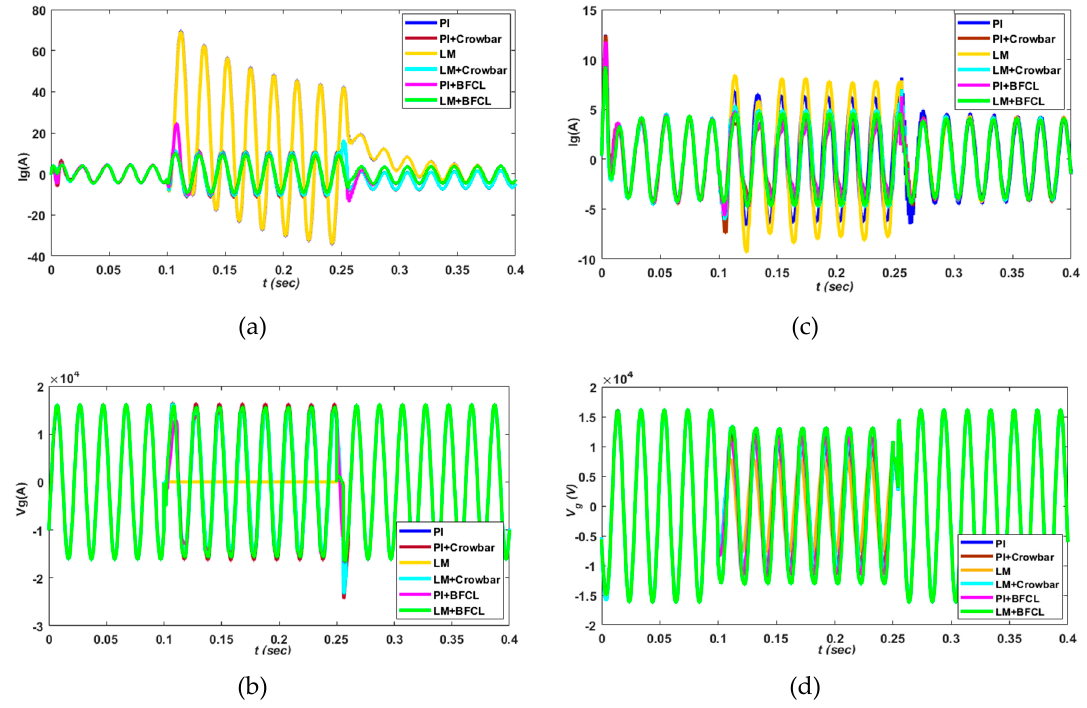
Figure 11. Grid currents and voltage during P-G 11 ( a, b ) and P-P 11 ( c, d ),